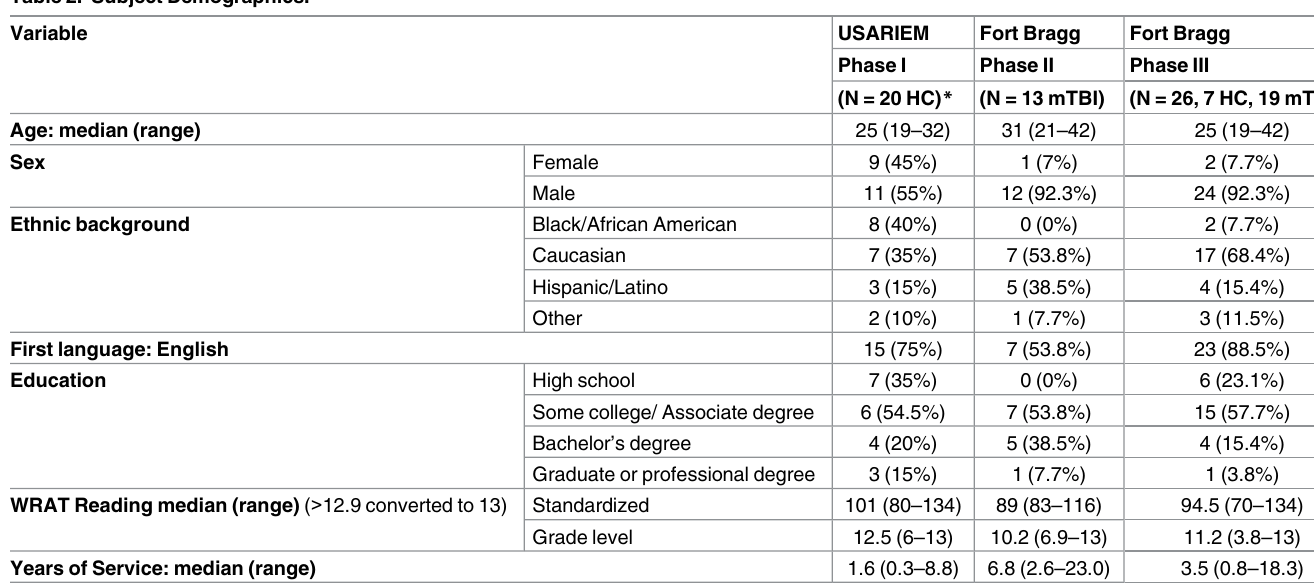
Table 2 describes demographic characteristics for subjects in each of the three phases of testing. Not all subjects completed all tasks. In order to avoid exceeding the maximum IRB approved test time, subjects who were slower to complete tasks were not asked to begin the last scheduled task. Some subjects did not complete testing due to overlapping scheduling